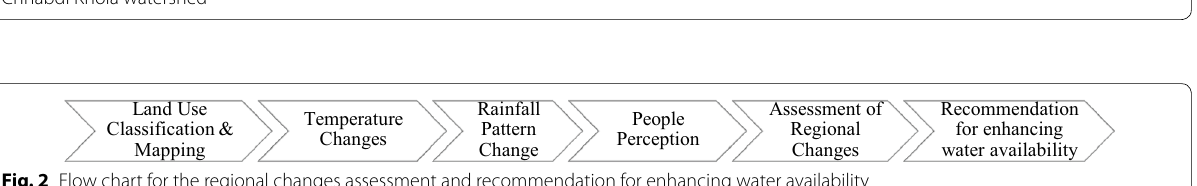
Fig. 1 Study area illustrating research districts with watersheds A Bhoti Khola watershed; B Gharmi Khola watershed; C Guhe Khola watershed; D Chhabdi Khola watershed